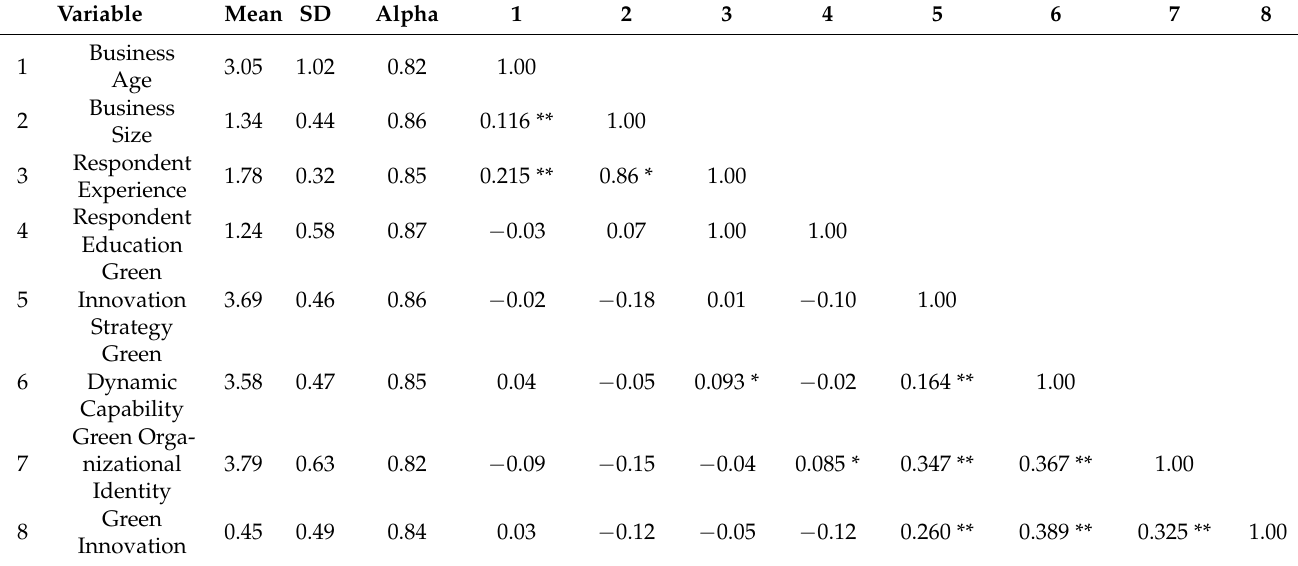
Table 3. Descriptive and Correlation